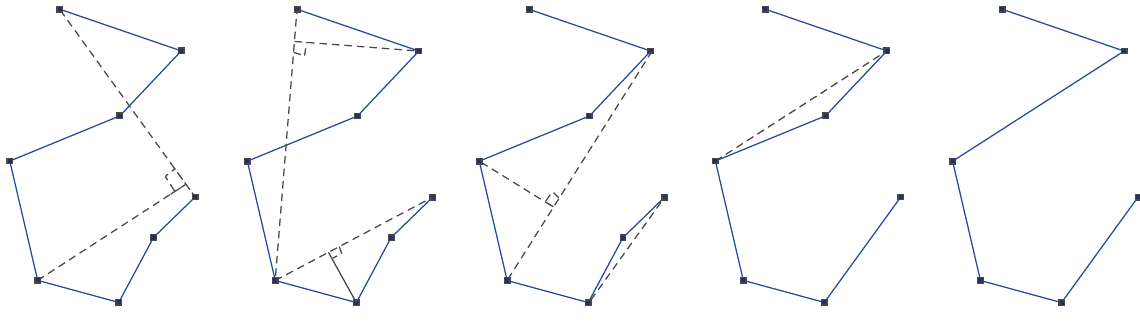
Figure 6: Douglas-Peucker algorithm procedure.